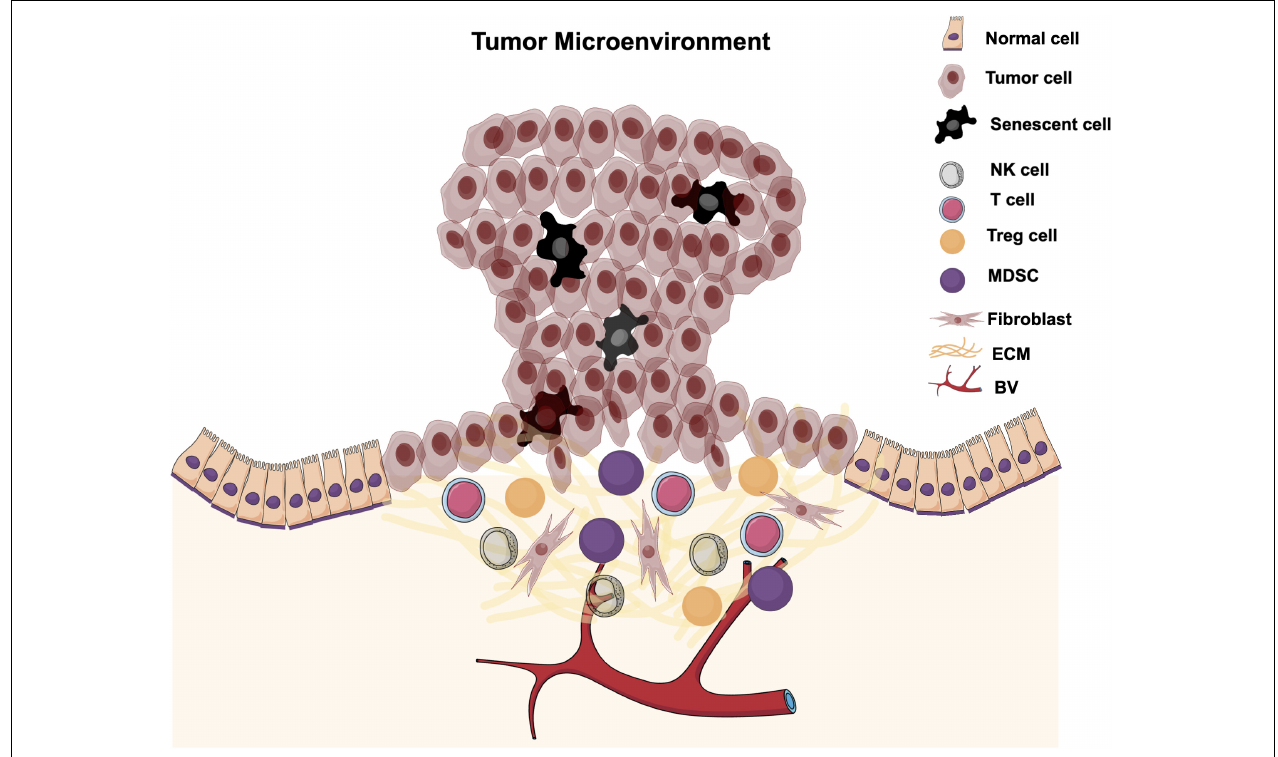
FIGURE 3 | Tumor microenvironment. The tumor microenvironment is the local area surrounding a tumor and is infiltrated with different cellular components and factors. TMEs are induced and modified by interaction with tumor cells to promote tumor progression and